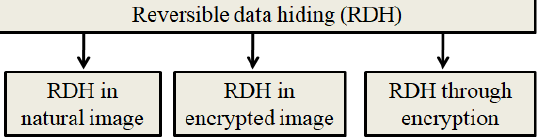
Figure 3. Types of RDH